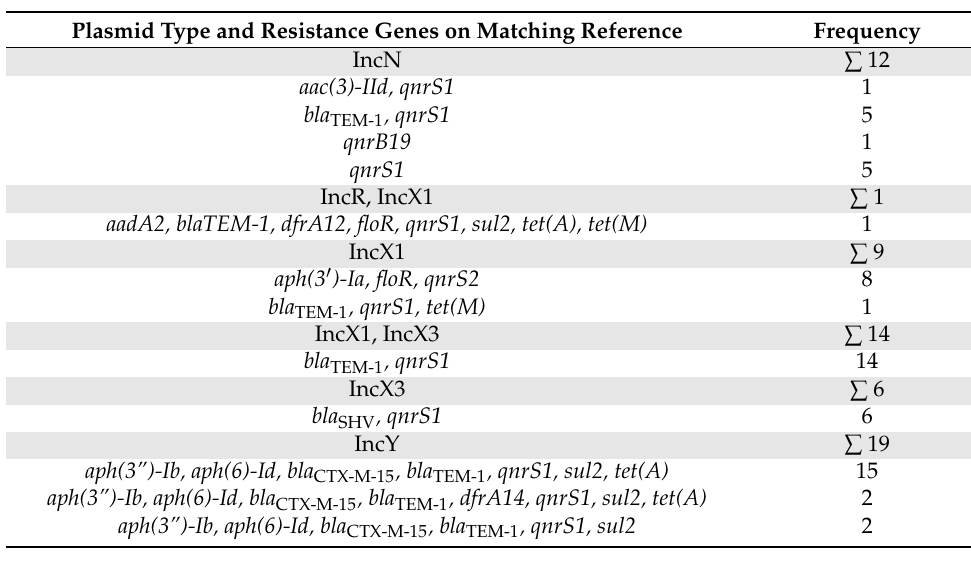
Table 4. Inc group and resistance genes of the best matching reference plasmid to the most prevalent plasmids carrying qnr -genes detected in this study. Identified with RefSNPer.